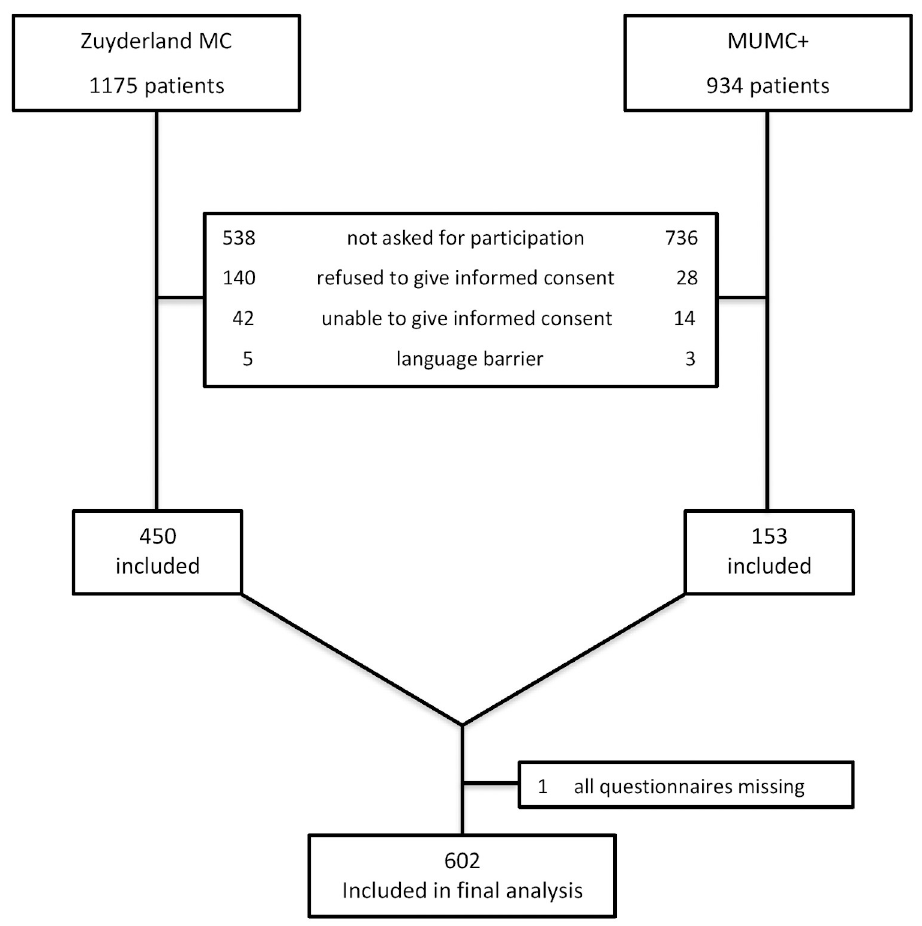
Fig 1. Flowchart of Zuyderland MC and MUMC+